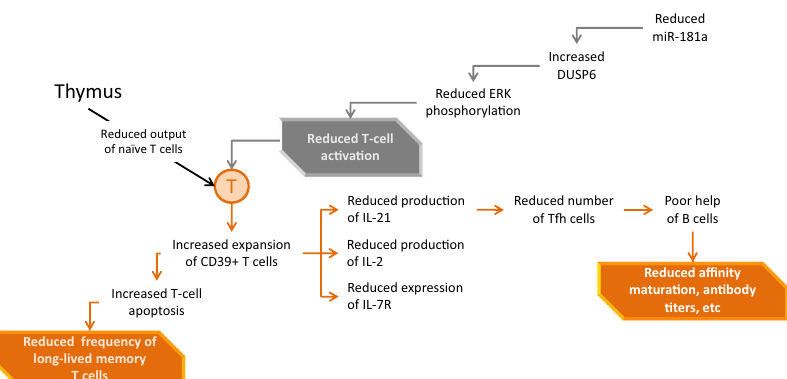
Fig. 2 T-cell changes associated with age. DUSP6 dual speci fi city phosphatase 6, miR-181a, microRNA-181a, ERK extracellular signal-regulated kinases, Tfh T follicular